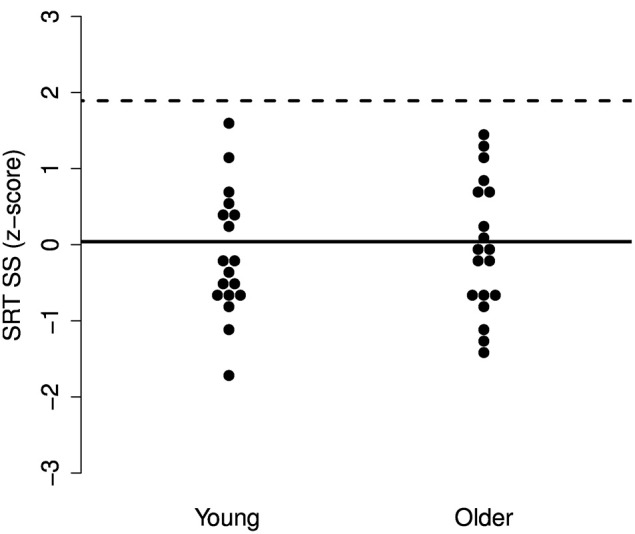
Individual z-scores for the SRTs in SS noise. The solid line indicates the mean for the young adults and the dotted line indicates the deviance threshold (1.65 SD above the mean for the young adults). No deviant older adults were identified.